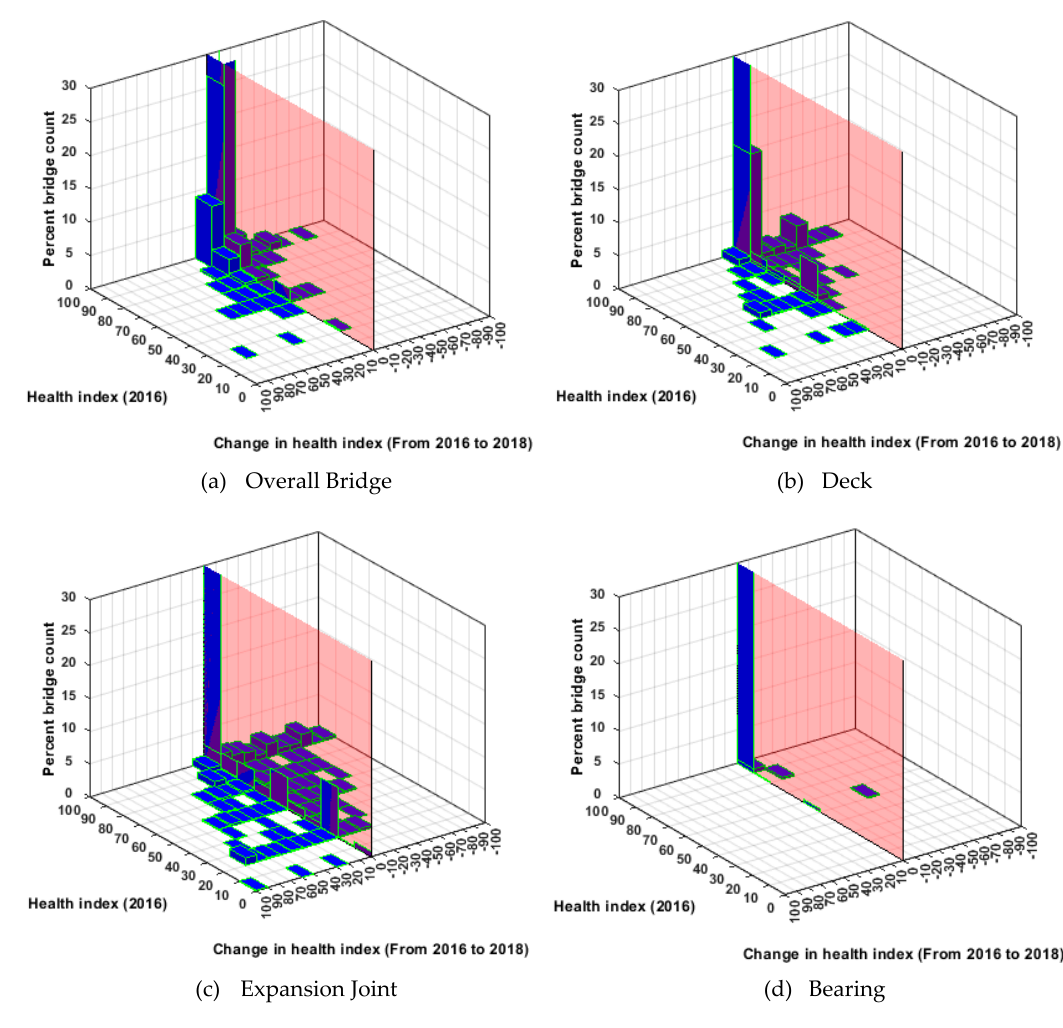
Figure 4. NHS bridge performance in Georgia. ( a ) Overall Bridge; ( b ) Concrete Deck; ( c ) Expansion Joint; ( d ) Bearing.